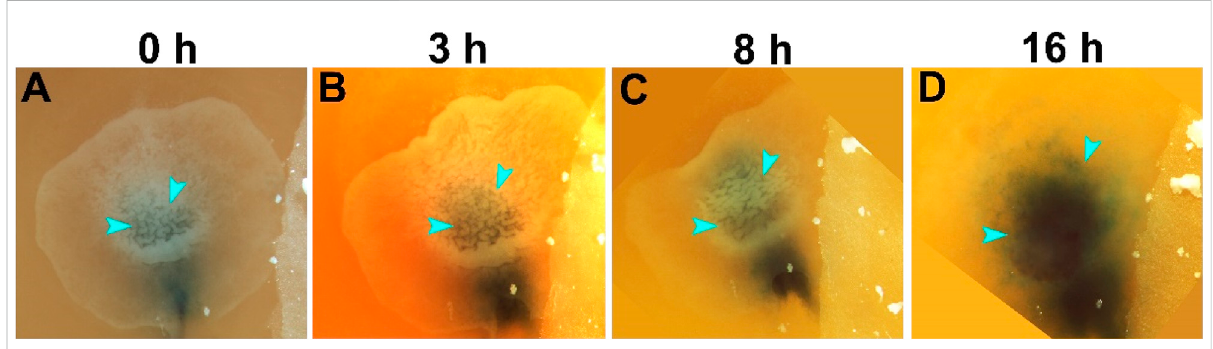
FIGURE 1 Morphological changes in embryos during the resumption phase. Embryos were stored for 28 days at 18 ° C ( n = 22 embryos). The cellular changes during the resumption phase were demonstrated in a series of time-course images, at the beginning of incubation at 37.8 ° C, at time 0 (A) , and 3, 8, 16 h later ( B – D , respectively). The dark color underneath the blastoderm is Fast Green dye, injected to highlight the contours of the embryos.Whileatthe fi rsthoursofincubationafterstorage,theembryosarethickerwithdeeprecessesintheepiblast( A – C ,arrowheads),these recesses gradually disappear such that within 16 h of incubation, the recesses are no longer visible and the embryo becomes transparent ( D , arrowheads).